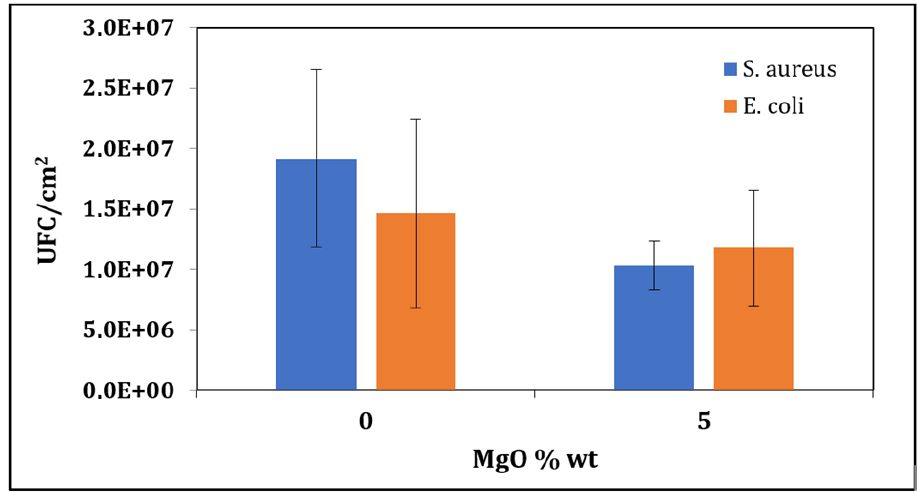
Figure 27. Antibacterial assay on membrane spacer PA11 and PA11 + MgO 5% (process 2).